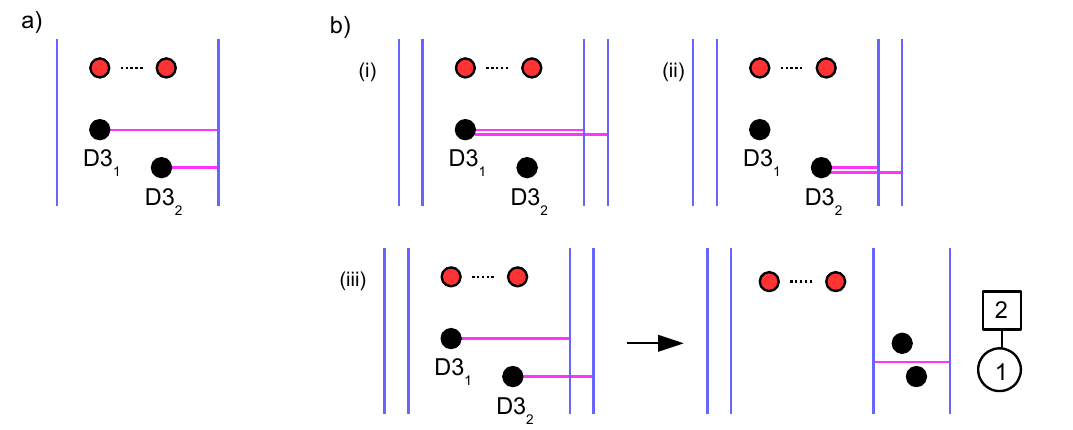
Figure 3 . Setup realising abelian contributions: a) A single contribution for V Three contributions for V SMM described by the quiver in (cid:12)gure